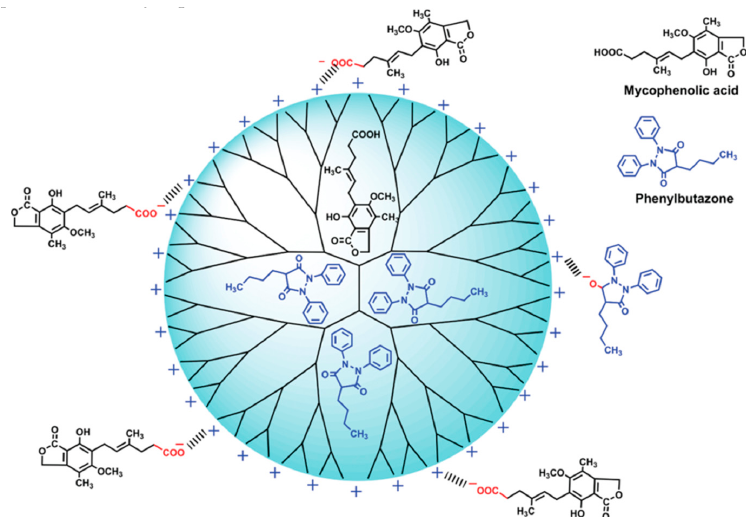
Figure 33. Interaction models for a ternary host–guest system consisting of dendrimer/mycophenolic acid/phenylbutazone. Reprinted with permission from [98]. Copyright 2009 American Chemical Society.